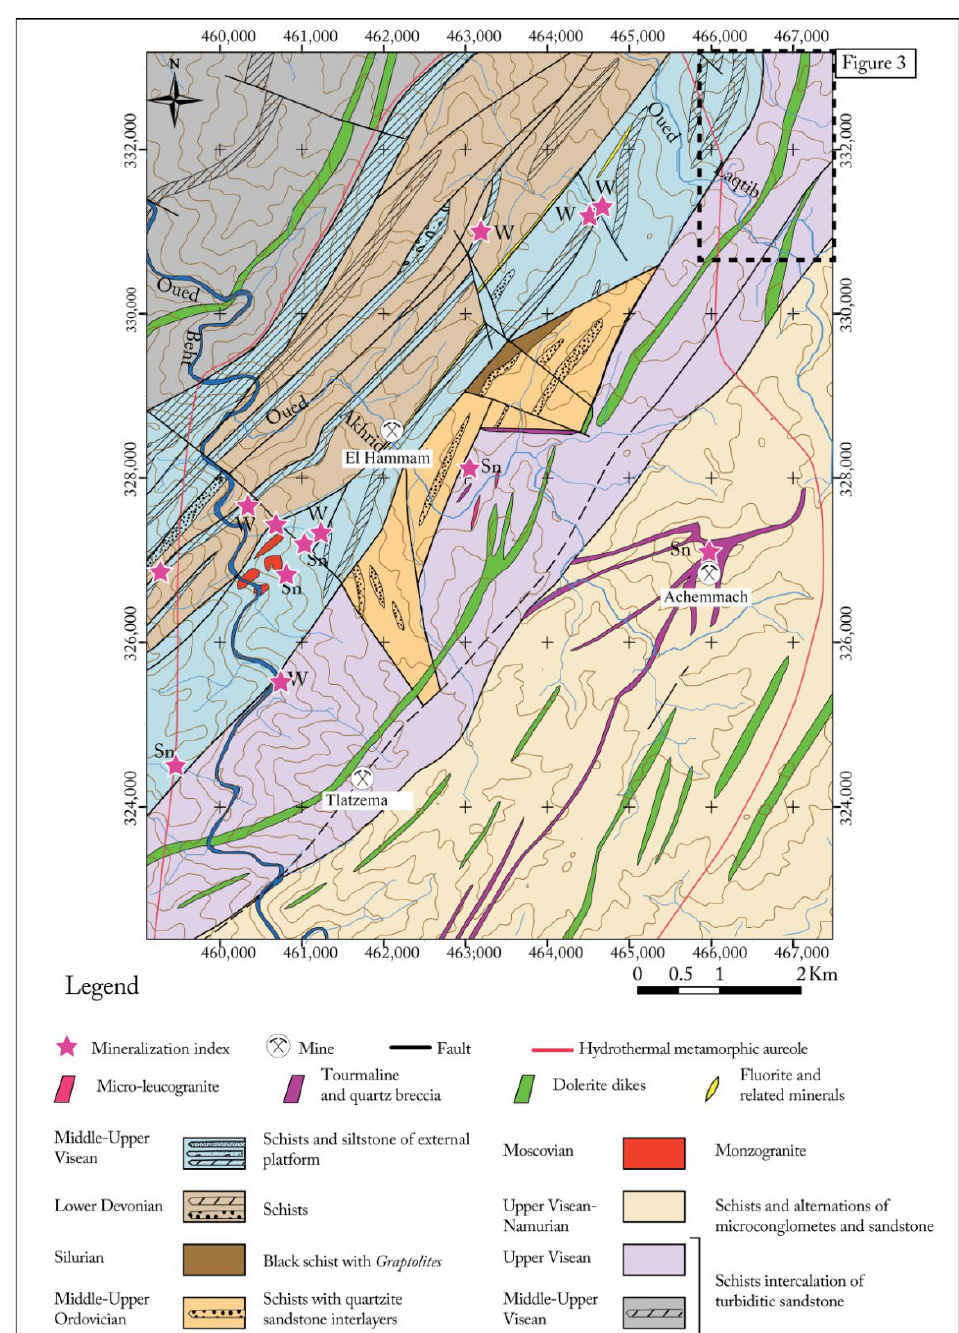
Figure 2. Geological map of the Achemmach-El Hammam district [11], displaying the location of the area under study. Sn: Tin, W: Tungsten. area under study. Sn: Tin, W: